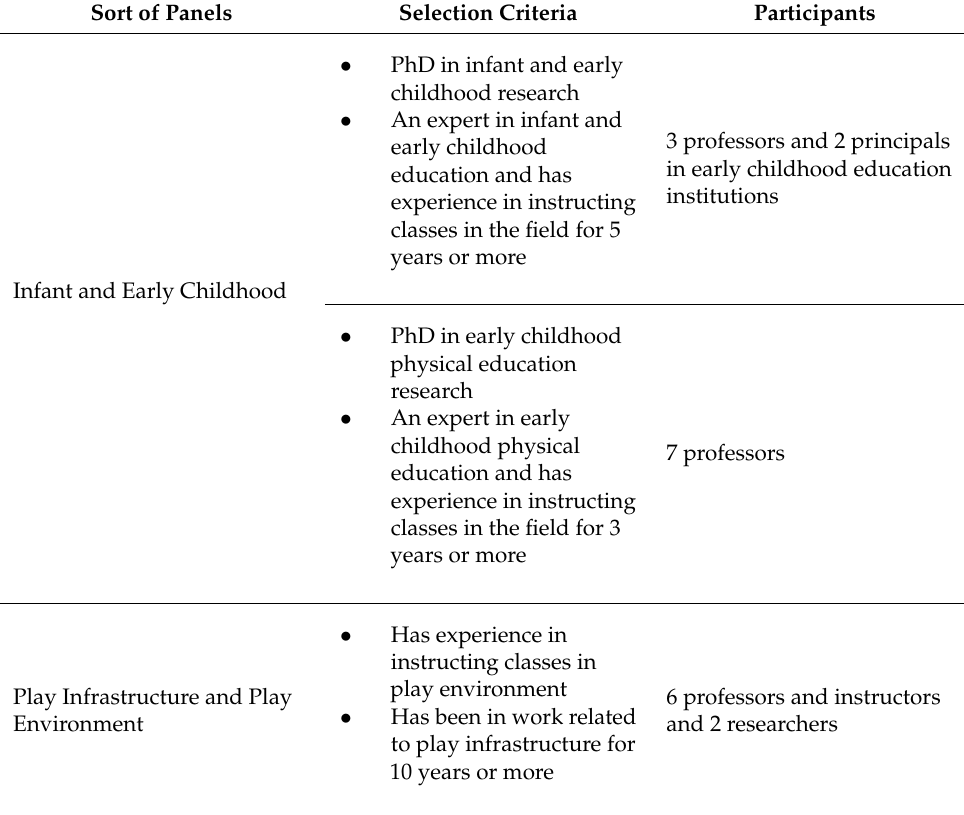
Table 3. Summary of Delphi Study Panels’